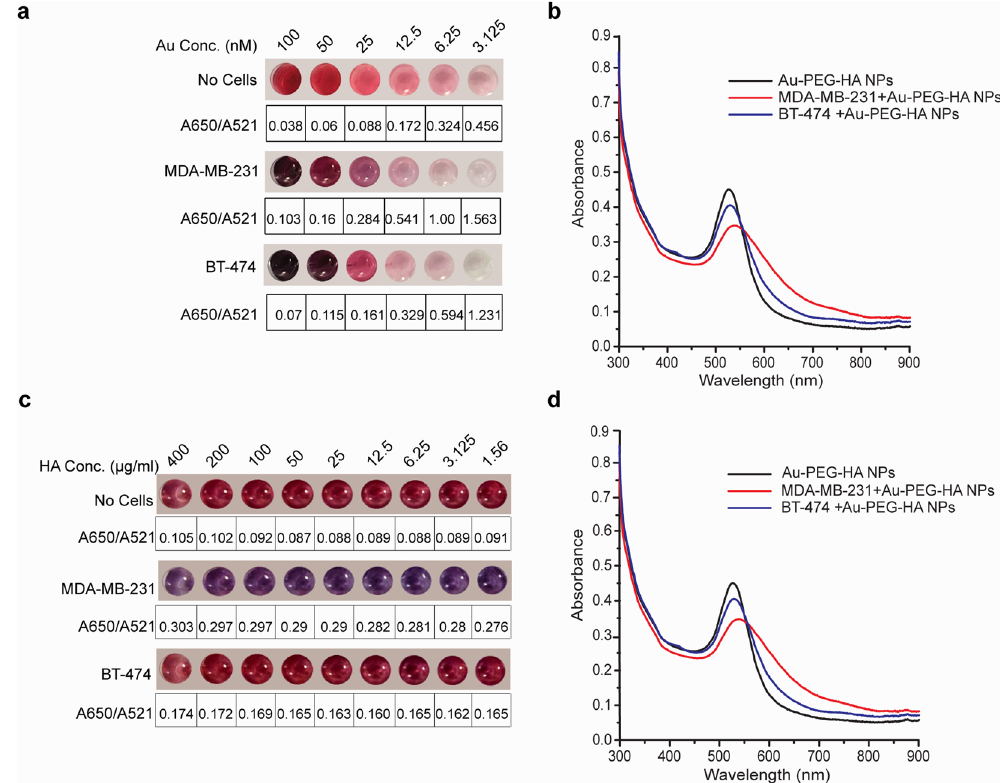
Figure 2. Optimization of Au and HA concentration in Au-PEG-HA NPs for cell detection. ( a ) Colorimetric changes (with A650/A521 ratio) of Au-PEG-HA NPs after incubation with MDA-MB-231 (50,000 cells) and BT-474 (50,000 cells) at varied Au concentration (100–3.125 nM) show pink-violet shift (521 nm–559 nm) in MDA-MB-231 and no shift in BT-474. ( b ) UV/Vis absorbance spectrum analysis of Au-PEG-HA NPs after incubation with MDA-MB-231 (50,000 cells) and BT-474 (50,000 cells) at 25 nM Au concentration. ( c ) Colorimetric changes (with A650/A521 ratio) of Au-PEG-HA NPs after incubation with MDA-MB-231 (50,000 cells) and BT-474 (50,000 cells) at varied HA concentration (400–1.56 µ g/ml) and 25 nM Au. ( d ) UV/Vis absorbance spectrum analysis of Au-PEG-HA NPs after incubation with MDA-MB-231 (50,000 cells) and BT- 474 (50,000 cells) at 100 HA µ g/ml concentration (25 nM